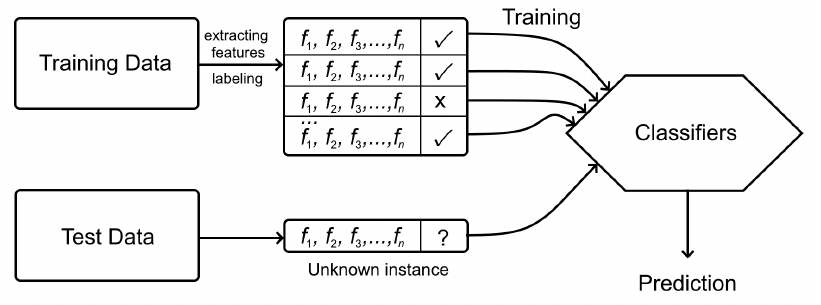
Figure 1. Scheme of the the process of constructing the defect prediction